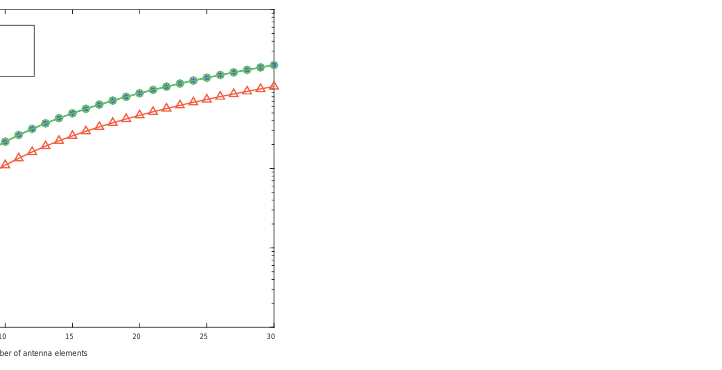
Figure 3. Computational complexity with respect to the number of antenna elements.